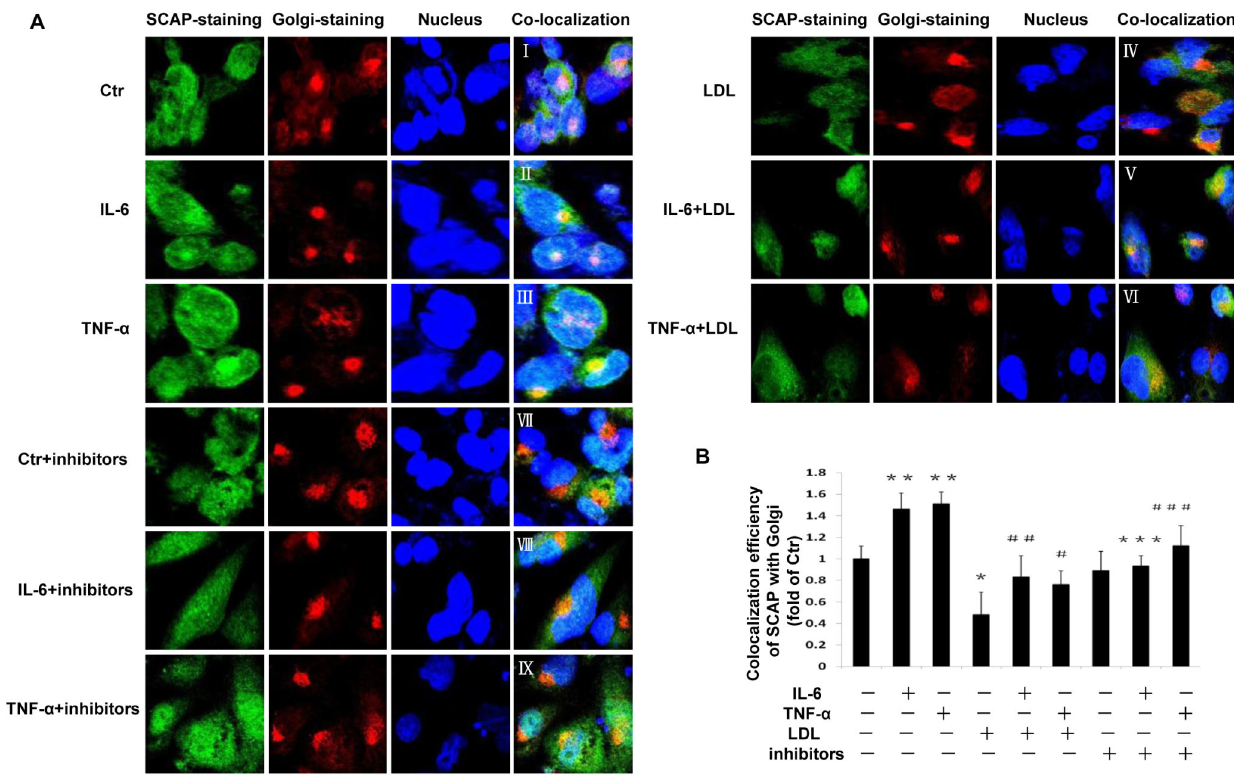
Figure 5. Effect of inflammatory cytokines and Golgi glycosylation enzyme inhibitors on protein translocation of SCAP from ER to Golgi in THP-1 macrophages. THP-1 macrophages plated in chamber slides were cultured in serum-free experimental medium or experimental medium with 40 ng/ml IL-6 or 50 ng/ml TNF- a in the absence or presence of 25 m g/ml LDL or glycosylation inhibitors (2.5 ng/ml kifunensine and 2.5 ng/ml swainsonine) for 24 h at 37 u C. The translocation of SCAP from the ER to the Golgi was investigated using confocal microscopy after dual- staining as described in the Materials and Methods section (A). The co-localization efficiency of SCAP with Golgi was quantified by Carl Zeiss Aim software. Results represent mean 6 SD from 4 separate fields (B). * P , 0.05 vs control; ** P , 0.01 vs control; *** P , 0.01 vs IL-6; # P , 0.05 vs LDL; ## P , 0.01 vs LDL; ### P , 0.05 vs TNF- a .